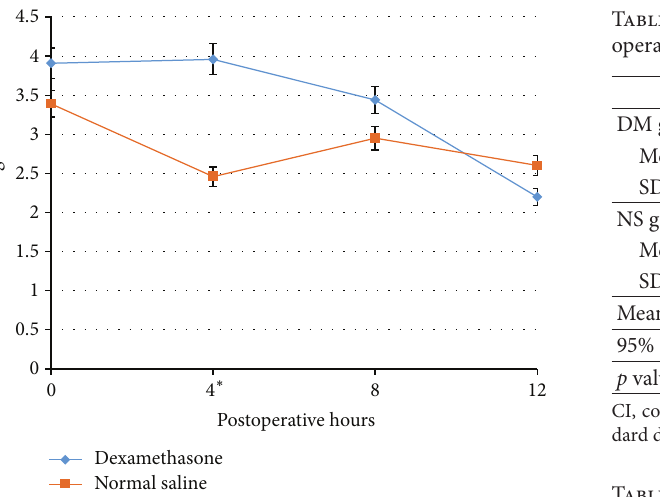
Figure 2: Pain intensity by visual analog scale (VAS) during the study period ∗ 𝑝 < 0.05 . The asterisk indicates that only at the 4th hour was the value considered statistically significant.